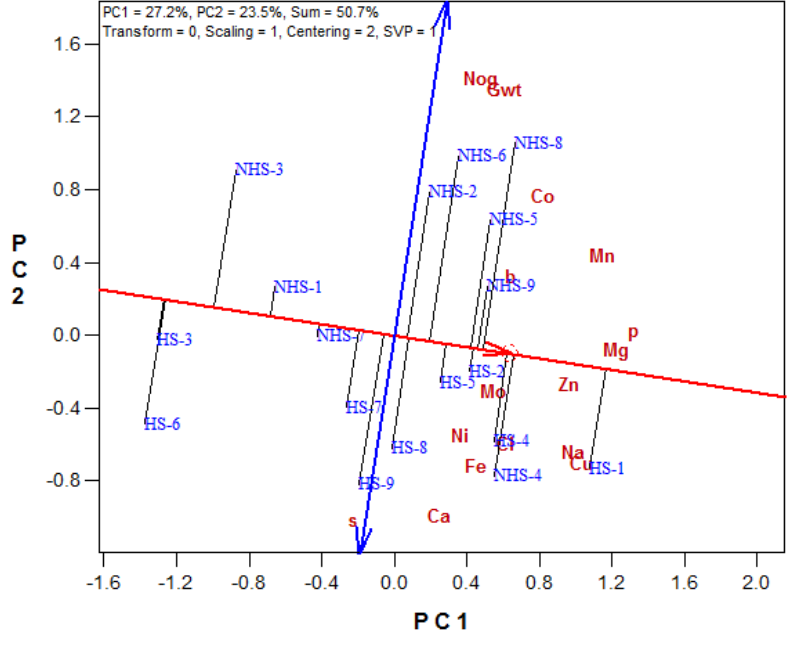
Figure 3. The mean performance and stability view of the treatment interactions. HS—heat ‐ stressed environment, NHS—non ‐ heat ‐ stressed environment, 1—WE3128 with MF, 2—WE3128 with MPM,